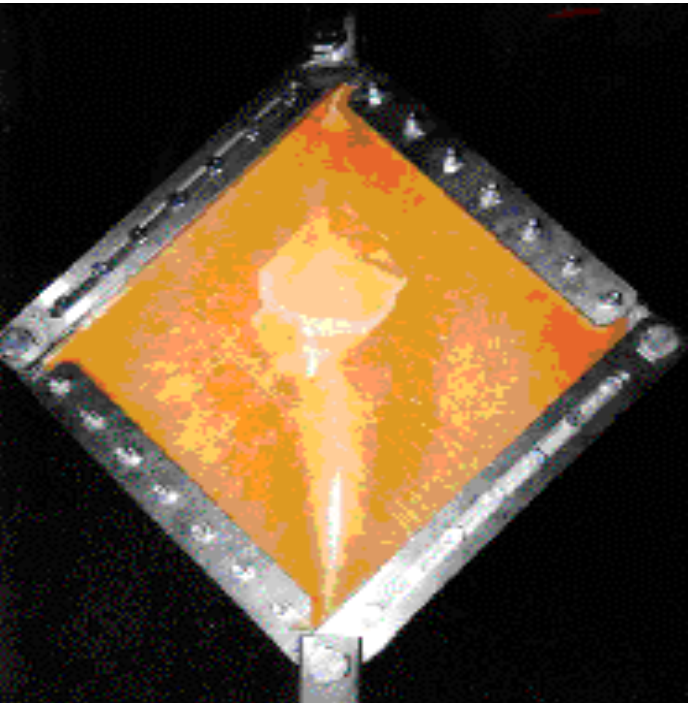
Figure 3. Buckling of plates (L x /L y = 1.0, h/L x = 0.012) subjected to transverse shear loads for structures without initial delamination—Ref. [12] (not to scale).